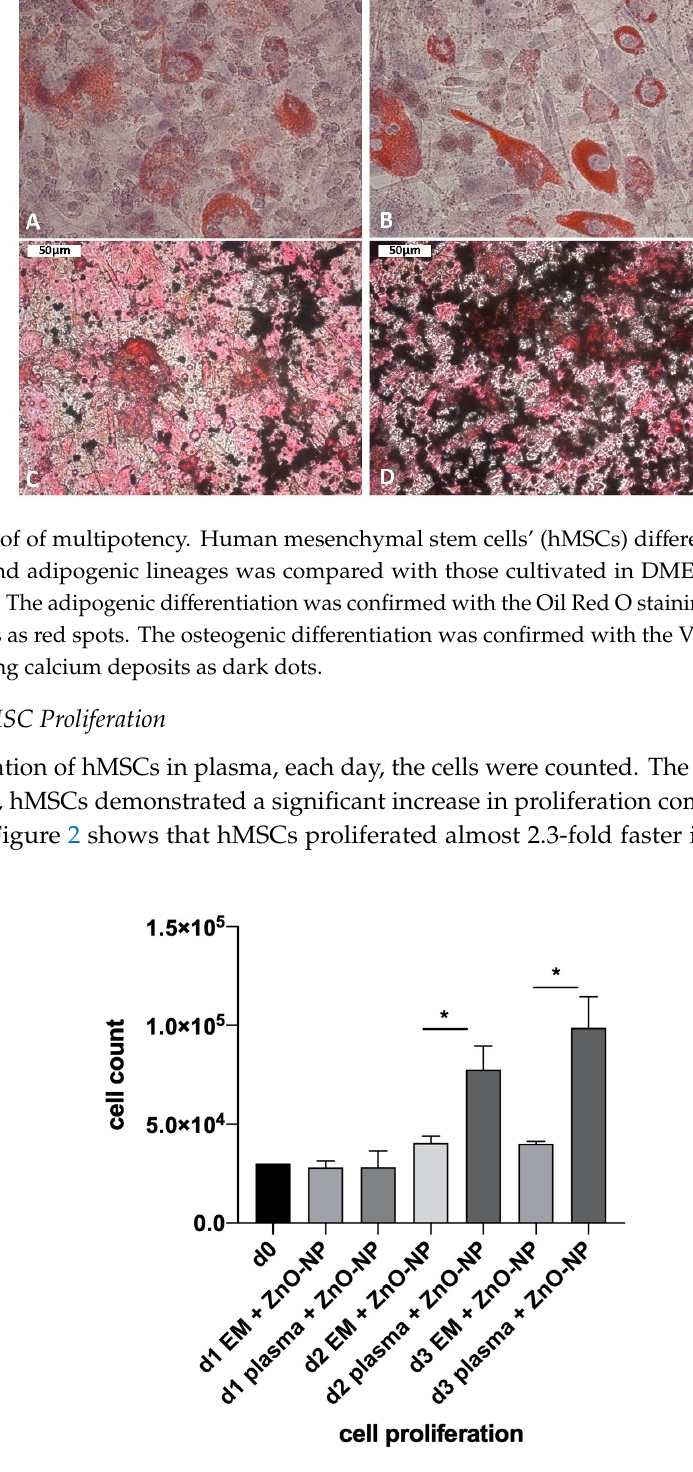
Figure 2. Cell proliferation analysis. hMSC proliferation was evaluated. The significance analysis was assessed as described above. Each day the cells were counted. hMSCs in plasma showed a significant enhancement of proliferation compared to cultivation in DMEM-EM at day 2 and 3. * indicates the statically significant